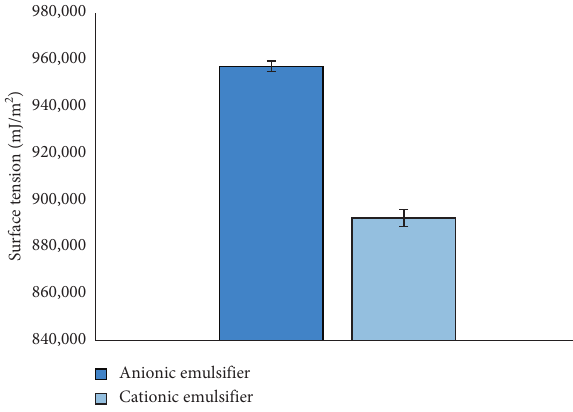
Figure 2: The surface tension results of the two kinds of the emulsifier.